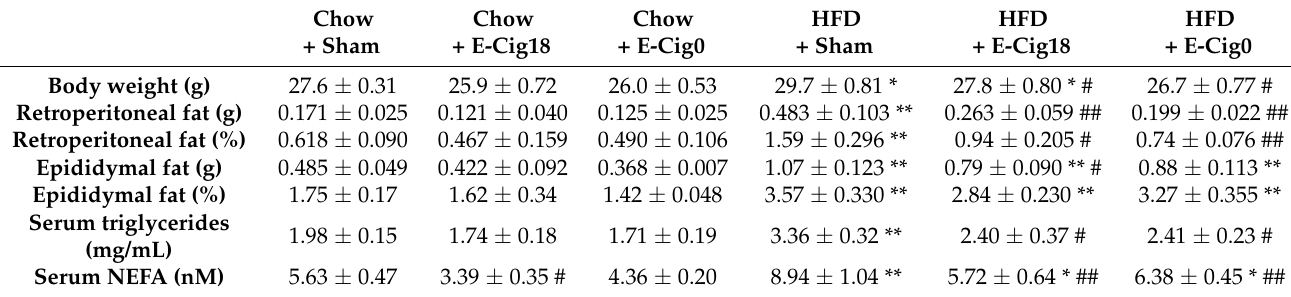
Table 1. Body weight and fat mass at 16